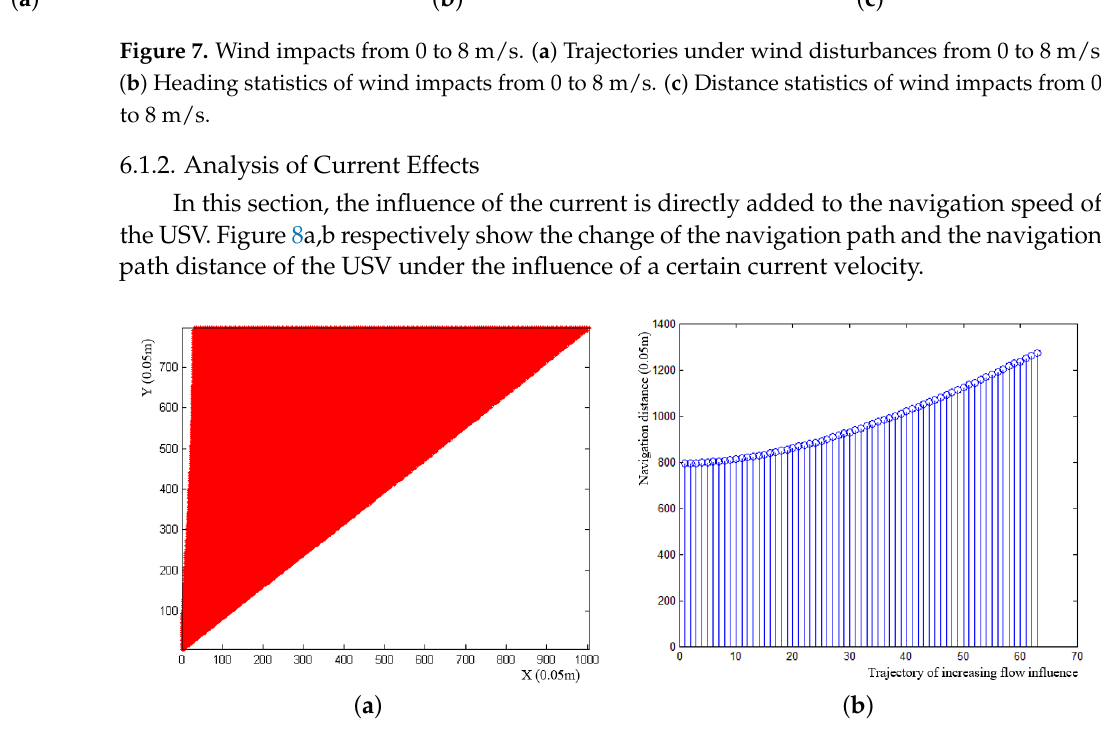
Figure 8. Current impacts at from 0 to 11.3 m/s. ( a ) Trajectory diagram under the current disturbances from 0 to 11.3 m/s. ( b ) Trajectory distance statistics under the current disturbances from 0 to 11.3